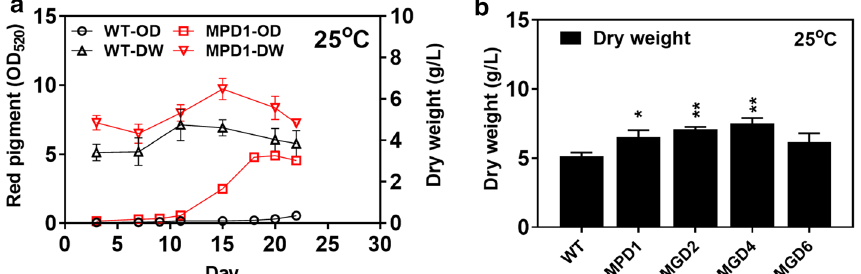
Fig. 5 Red pigment production and cell growth of mutants obtained by dual transposable systems at 25 °C. a The red pigment production of MPD1. b The dry weight of MPD1, MGD2, MGD4, MDS6. The value of the bar represents the highest biomass dry weigh at culture duration. WT, wild-type; DW, biomass dry weight. Determination of absorbance value of red pigment at wavelength of 520 nm (OD 520 ). Data of significance were shown in ** P < 0.01 and * P <